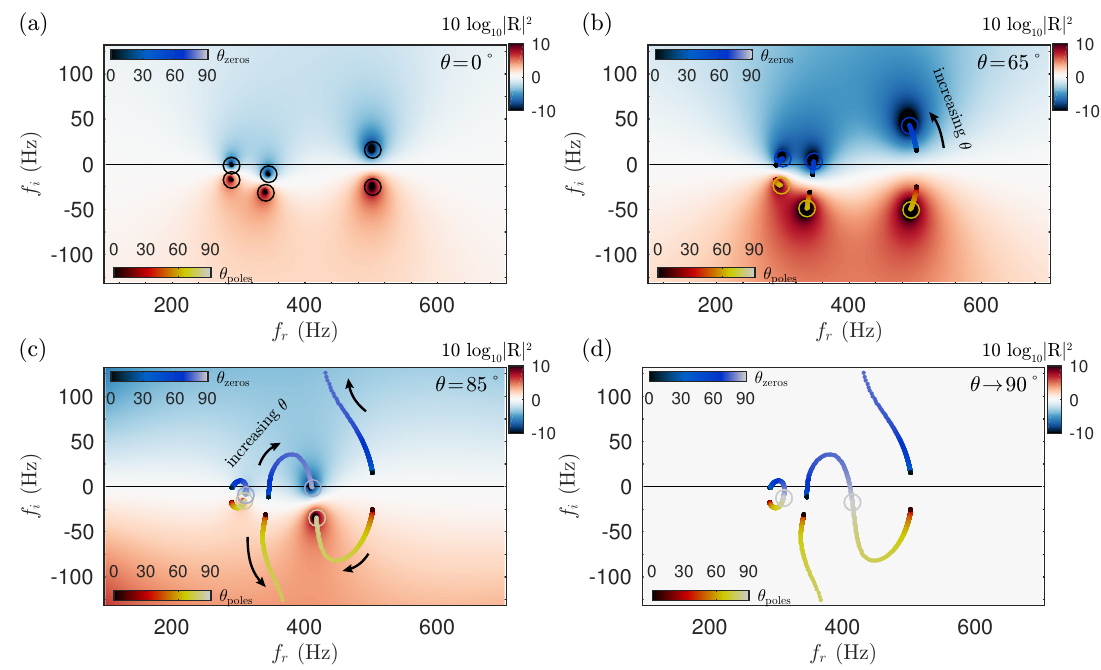
Figure 5. Complex frequency representation of the reflection coefficient for the metamaterial with N = 3 HRs, in logarithmic colour scale, for different angles of incidence. ( a ) θ = 0 ◦ ; ( b ) θ = 65 ◦ ; ( c ) θ = 85 ◦ ; ( d ) θ → 90 ◦ . The trajectories of the poles and the zeros of the reflection coefficient as the incidence angle is increased are plotted in coloured lines, corresponding to the blueish and reddish colour bars,